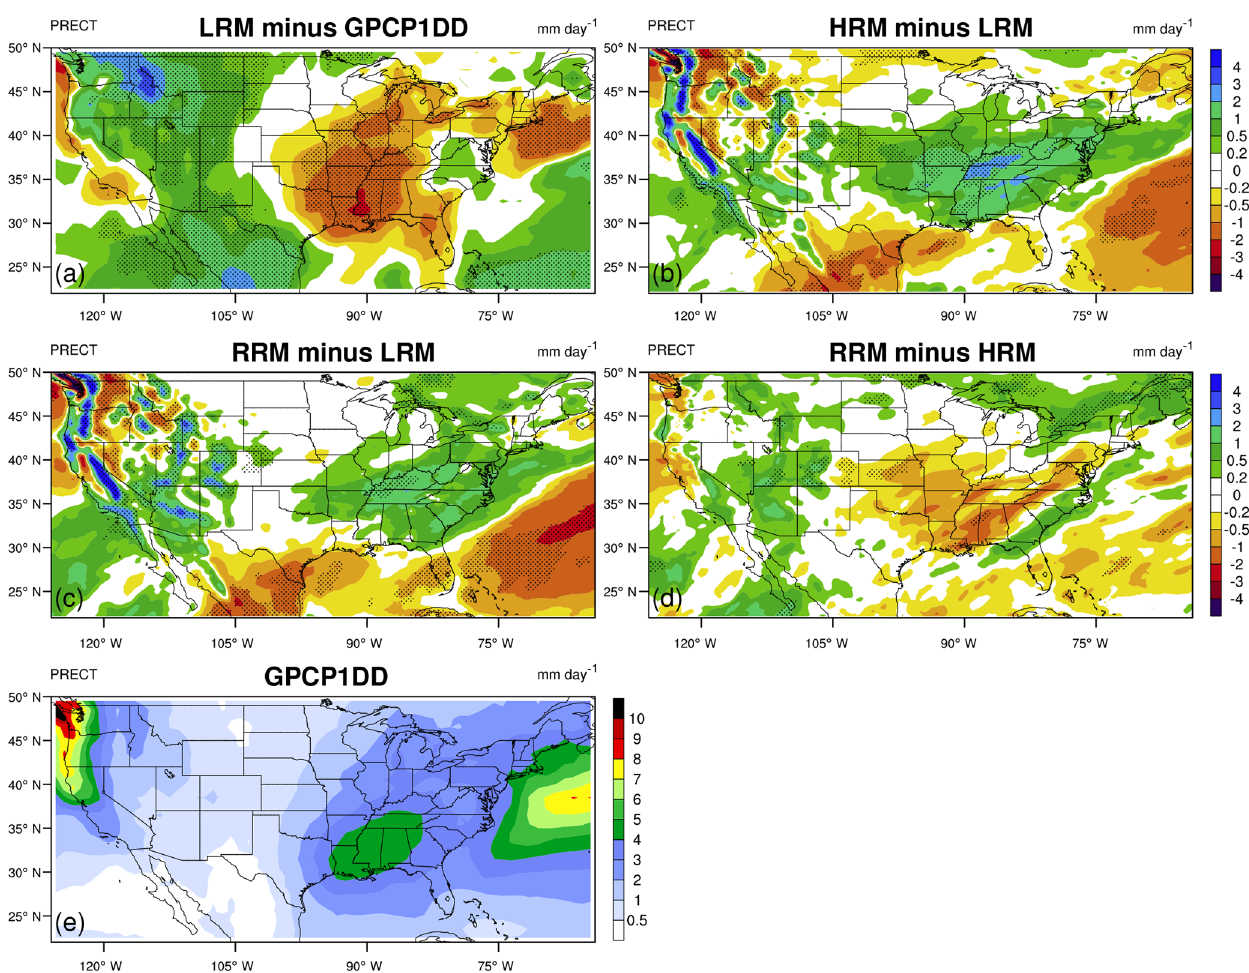
Figure 5. Same as Fig. 4, but for